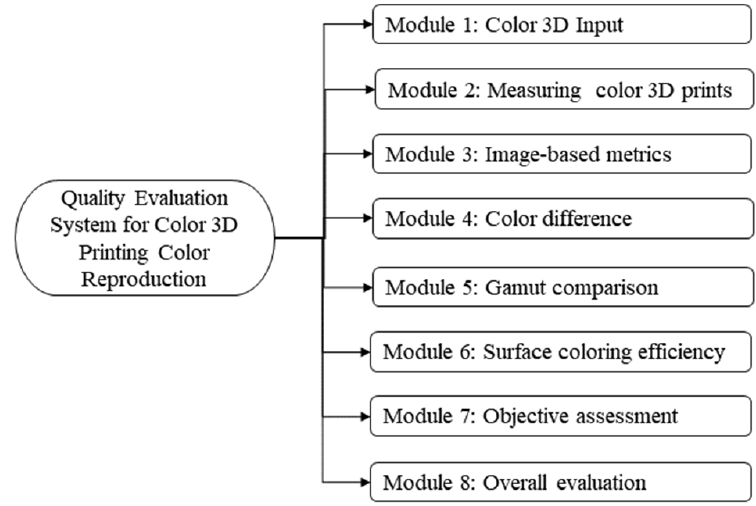
Figure 9. The basic architecture of the proposed system.